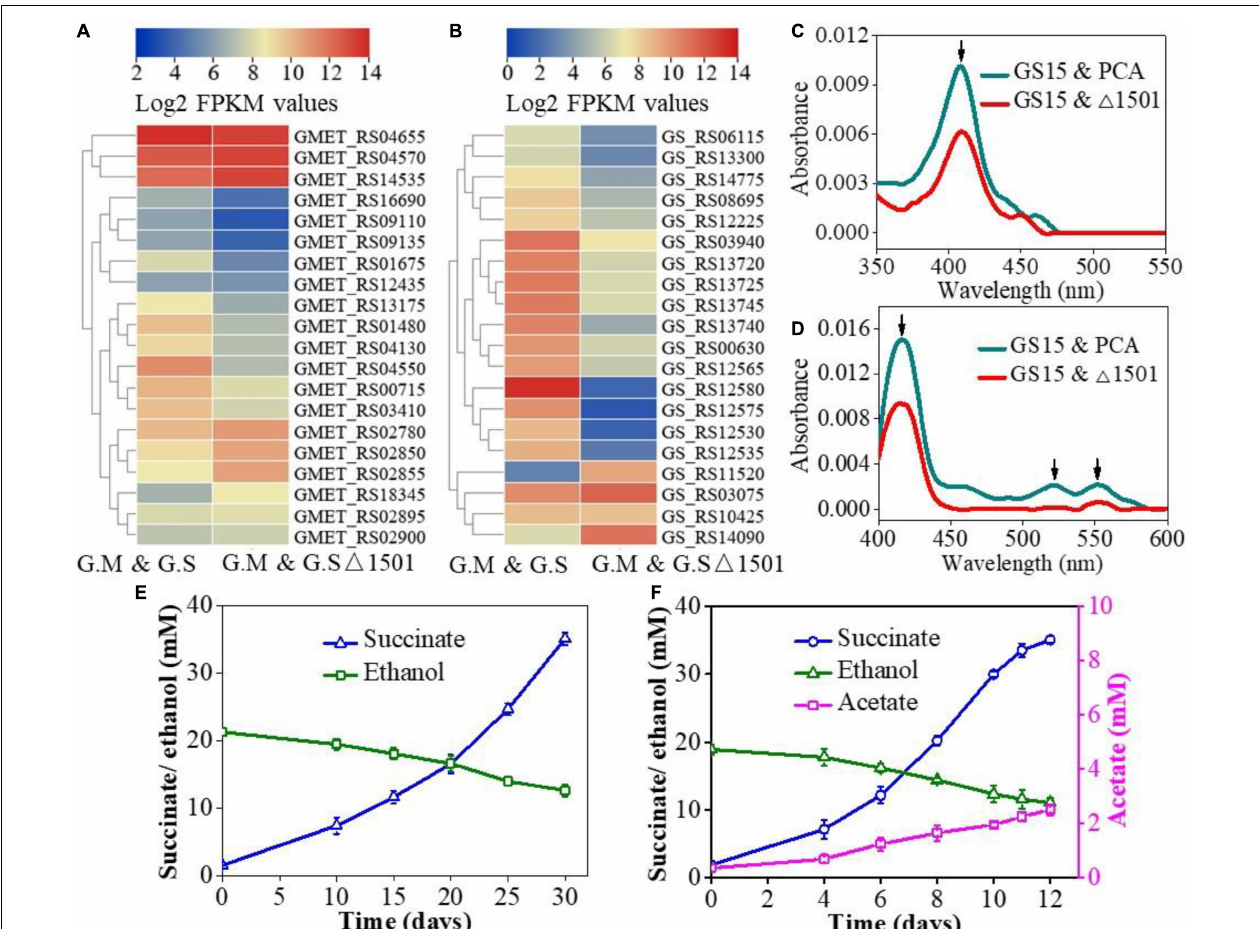
FIGURE 2 | Heat map comparison of c -type cytochromes ( c -Cyts)-related genes of Geobacter metallireducens ( G. metallireducens ) (A) and Geobacter sulfurreducens ( G. sulfurreducens ) (B) in the GS15 and PCA co-culture and the GS15 and PCA (cid:49) 1501 co-culture. UV-Vis spectra of oxidized c -Cyts (C) and reduced c -Cyts (D) in exopolysaccharide (EPS) from the co-cultures. Effects of magnetite addition on the syntrophic metabolism of the GS15 and PCA (cid:49) 1501 co-culture in the first generation (E) and metabolic stable period (F) .